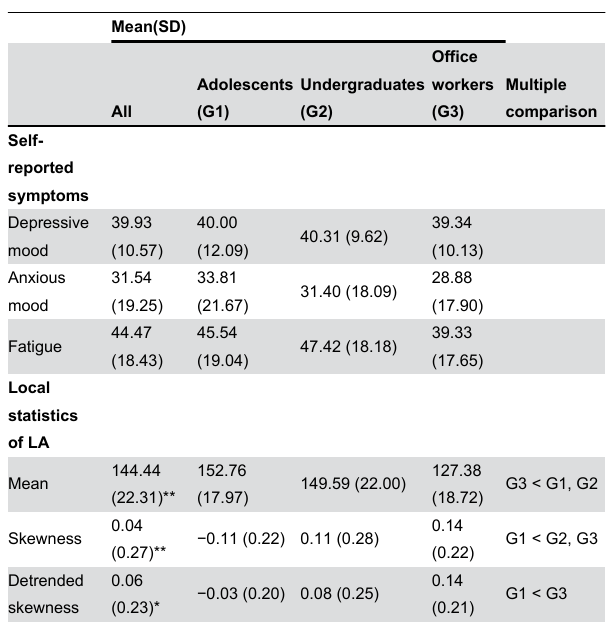
Table 1. Statistics of self-reported symptoms and local statistics of locomotor activity. LA: locomotor activity, SD : standard deviation. ** and * indicate significant group difference at p < 0.01 and p < 0.05, respectively.